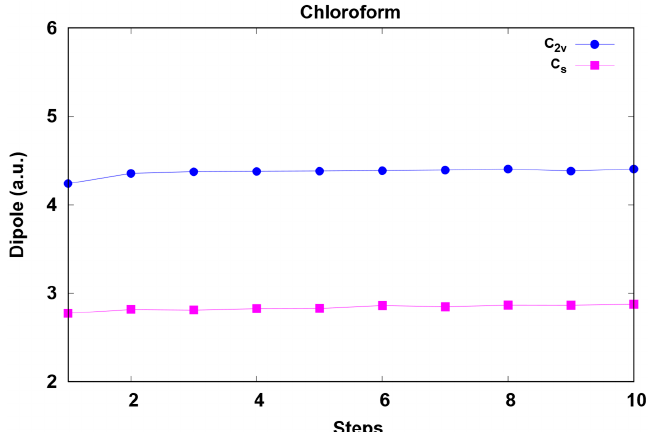
Table 1. MP2/(Li-aug)-cc-pVDZ results for bond lengths (Å) of the C s conformer in the gas phase and solution. In the case of chloroform, the values are convergent within an error bar of 0.001 Å. Length